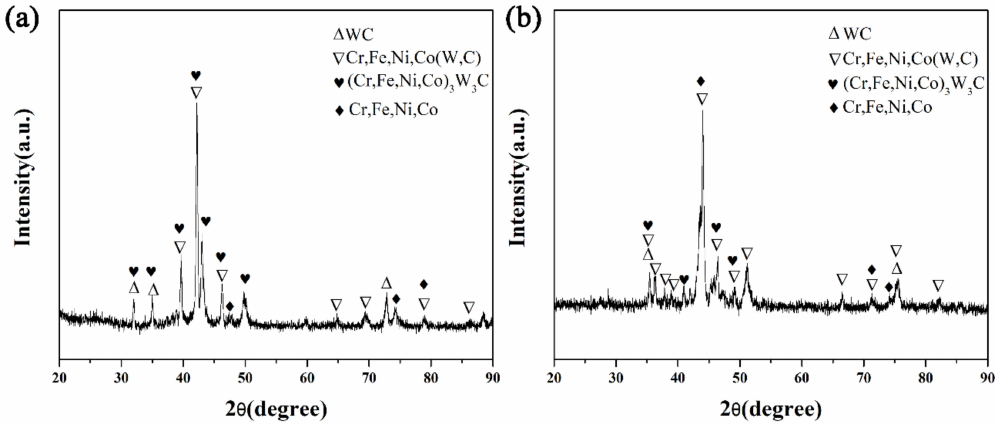
Figure 1. XRD patterns of the coatings with different Fe-based amorphous alloy contents. ( a ) 5%, ( b )